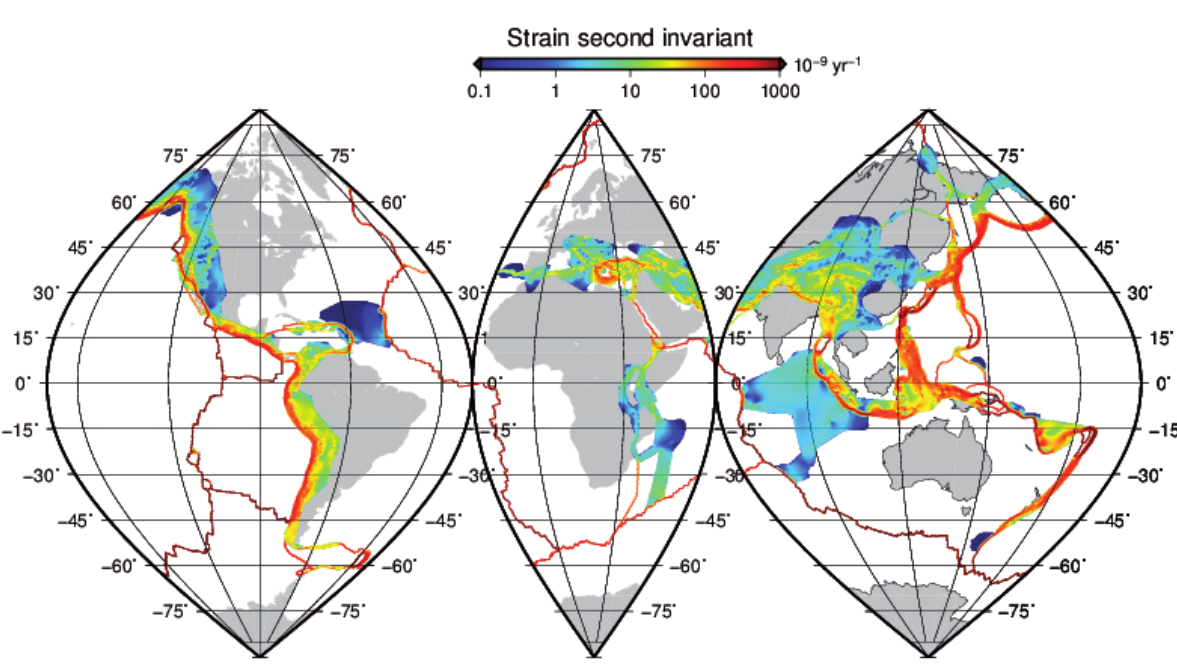
Figure 4. Geographic distribution of the second invariant of the strain tensor as defined in the version 2.1 of the GEM Global Strain Rate model [Kreemer et al. 2014a,